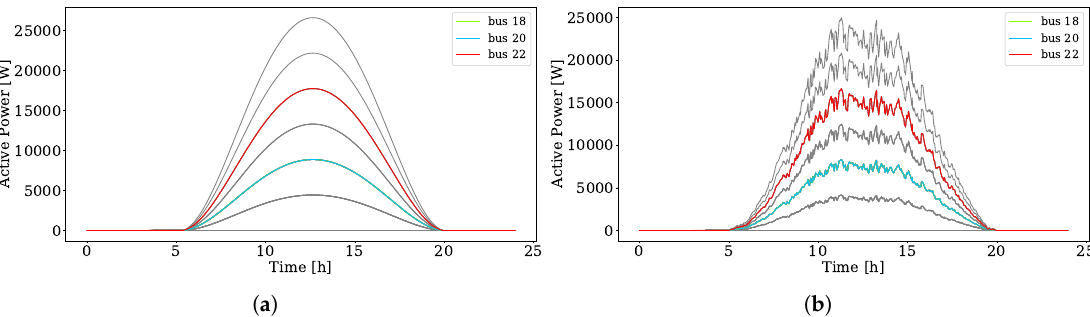
Figure 6. Generated PV profiles for clear sky and cloudy weather conditions. ( a ) Photovoltaic (PV) profiles under clear sky conditions. ( b ) PV profiles under cloudy